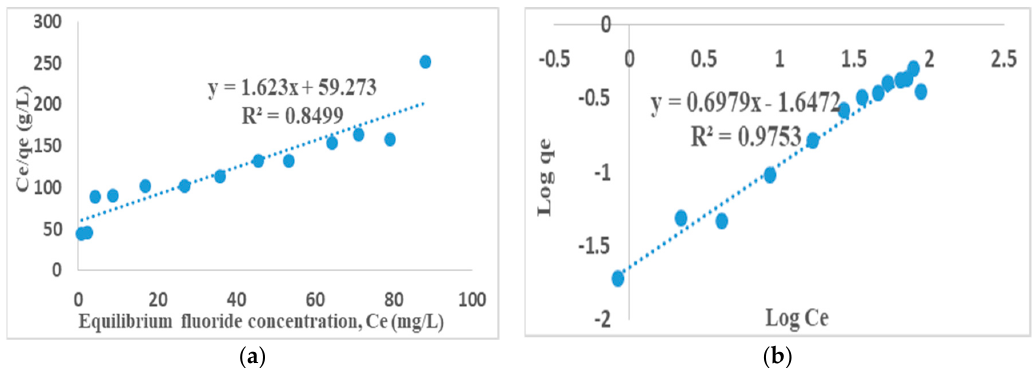
Figure 9. (a) Langmuir, and (b) Freundlich adsorption isotherms. (10 mg/L fluoride concentrations, 2 g/100 mL adsorbent dosage and 60 min contact time at 250 rpm. Fluoride concentration was varied from 1 to 100 mg/L).